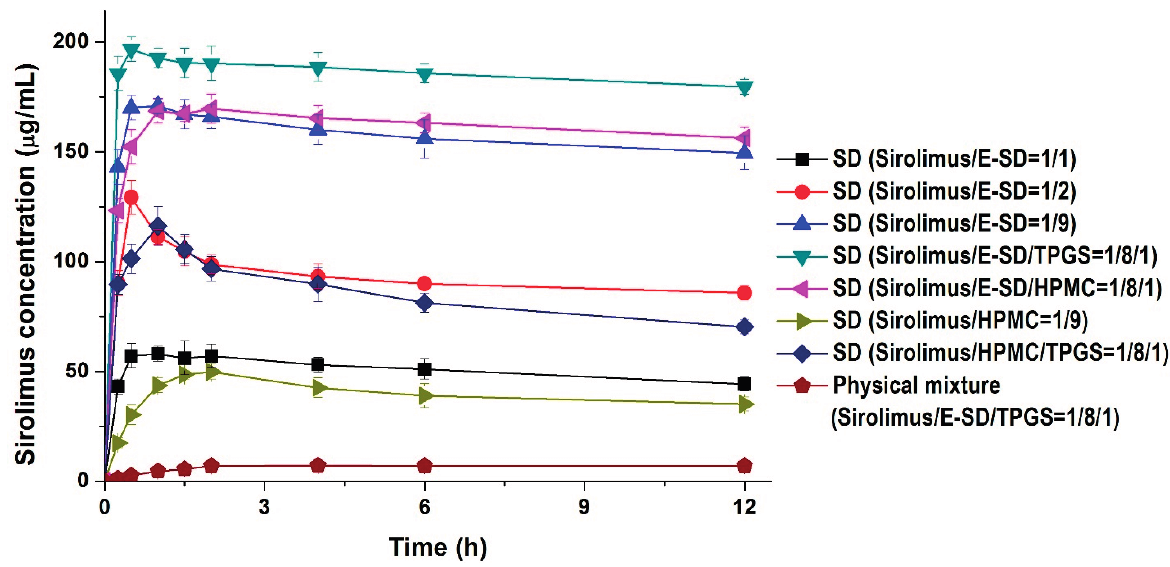
Figure 4. Kinetic solubility profiles of sirolimus-loaded solid dispersions. Data are expressed as the mean ± standard deviation ( n =